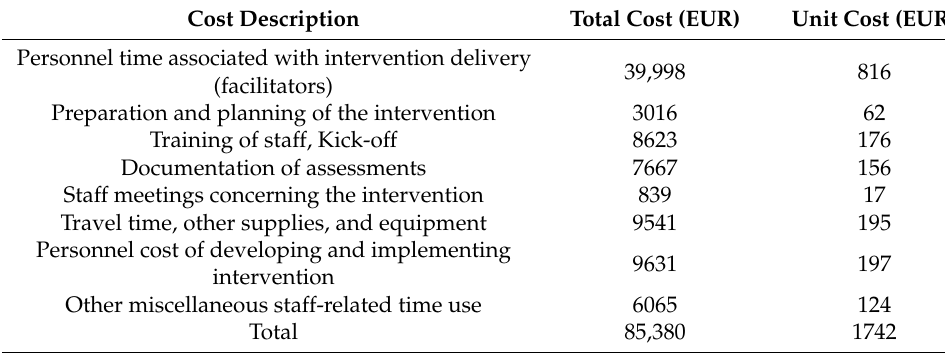
Table 3. Costs of the ProMES intervention ( n =